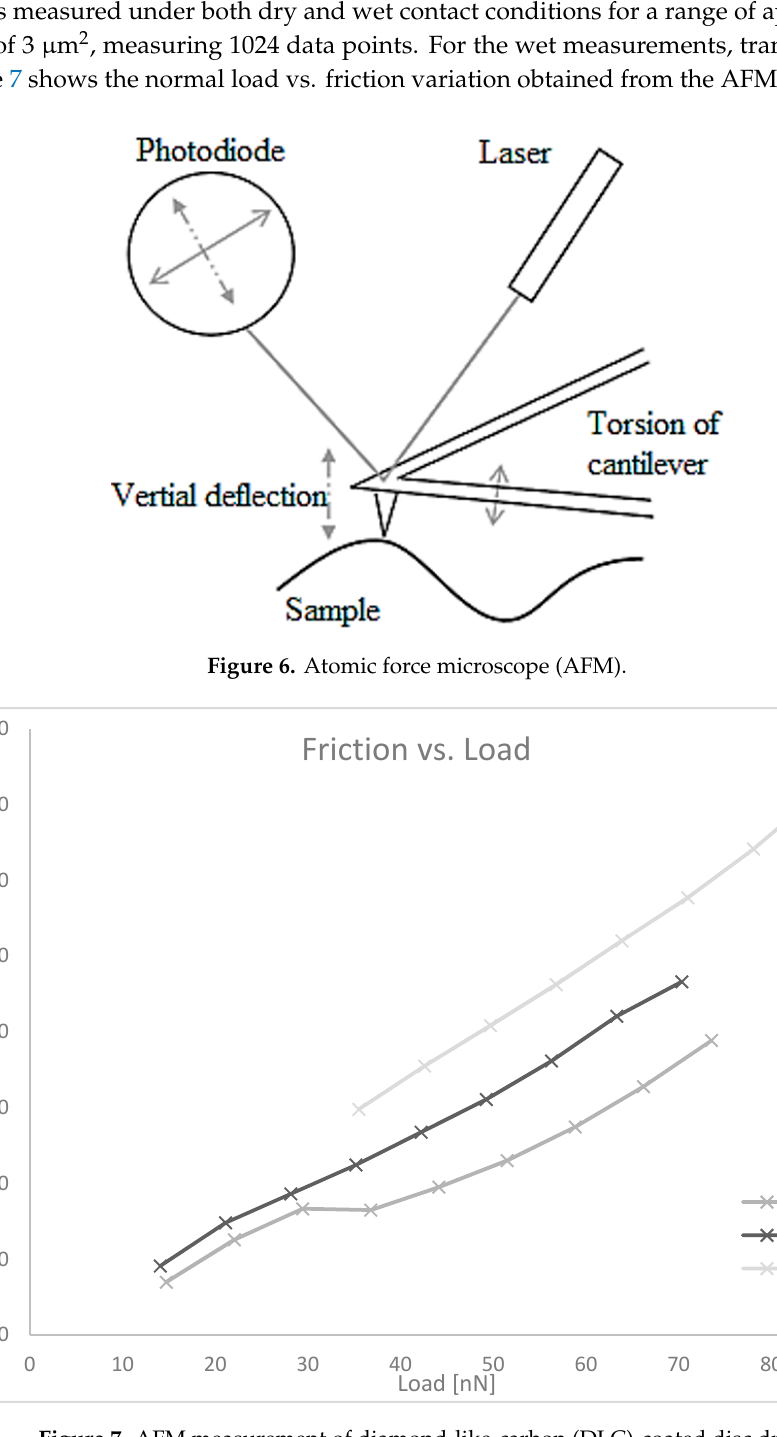
Figure 7. AFM measurement of diamond-like-carbon (DLC)-coated disc dry.